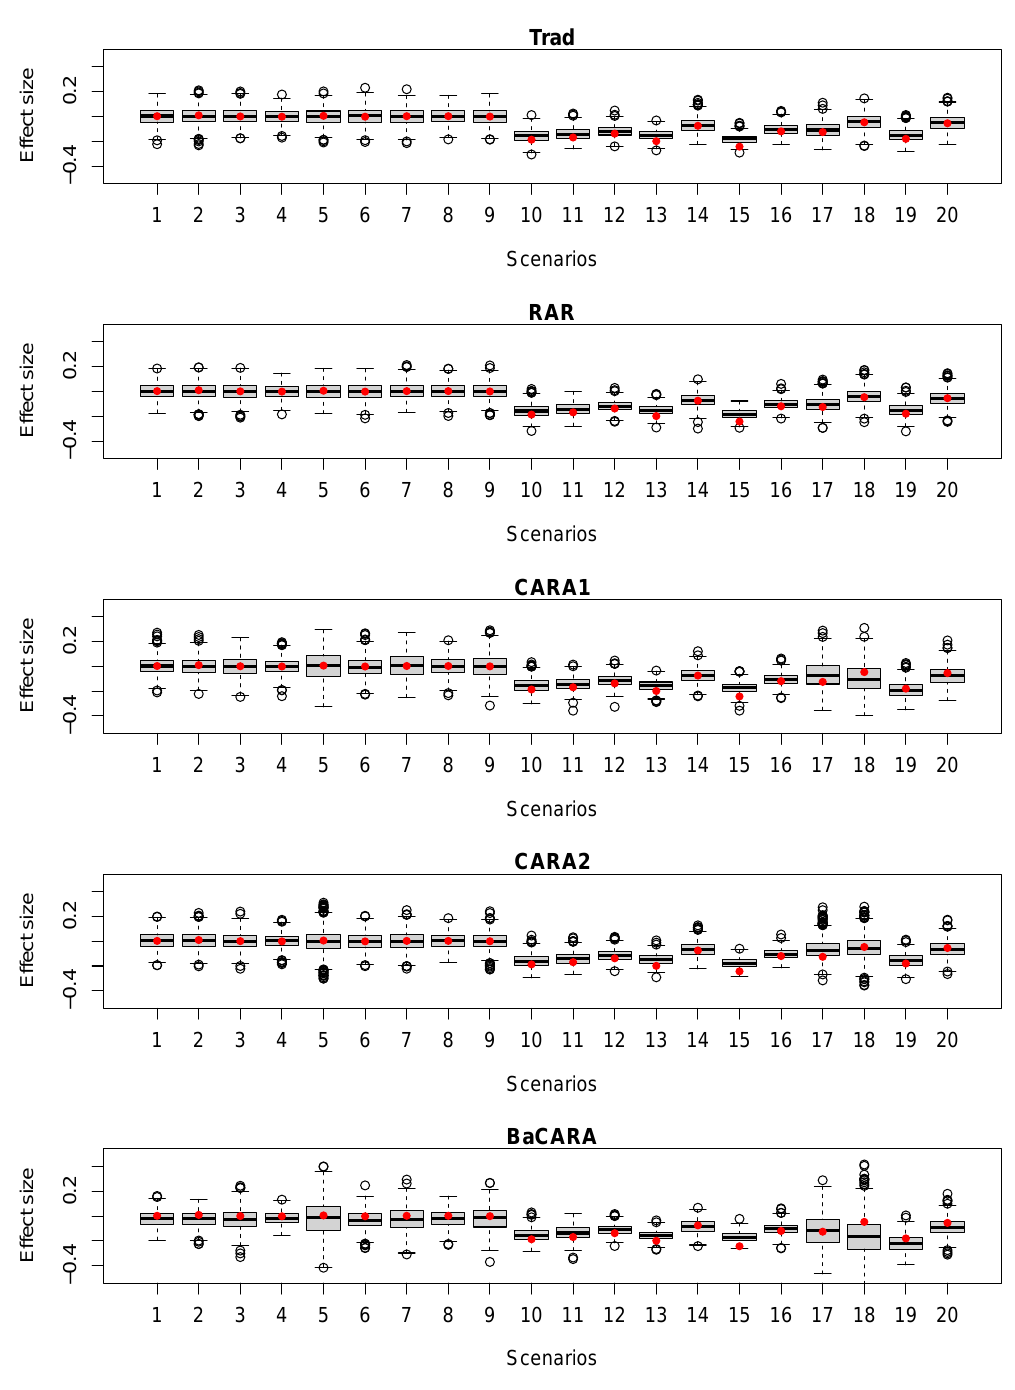
Figure 2. Boxplots of the estimated difference in the response probability between A and B (i.e., effect size) at final analysis. The red dots indicate the true effect sizes of the